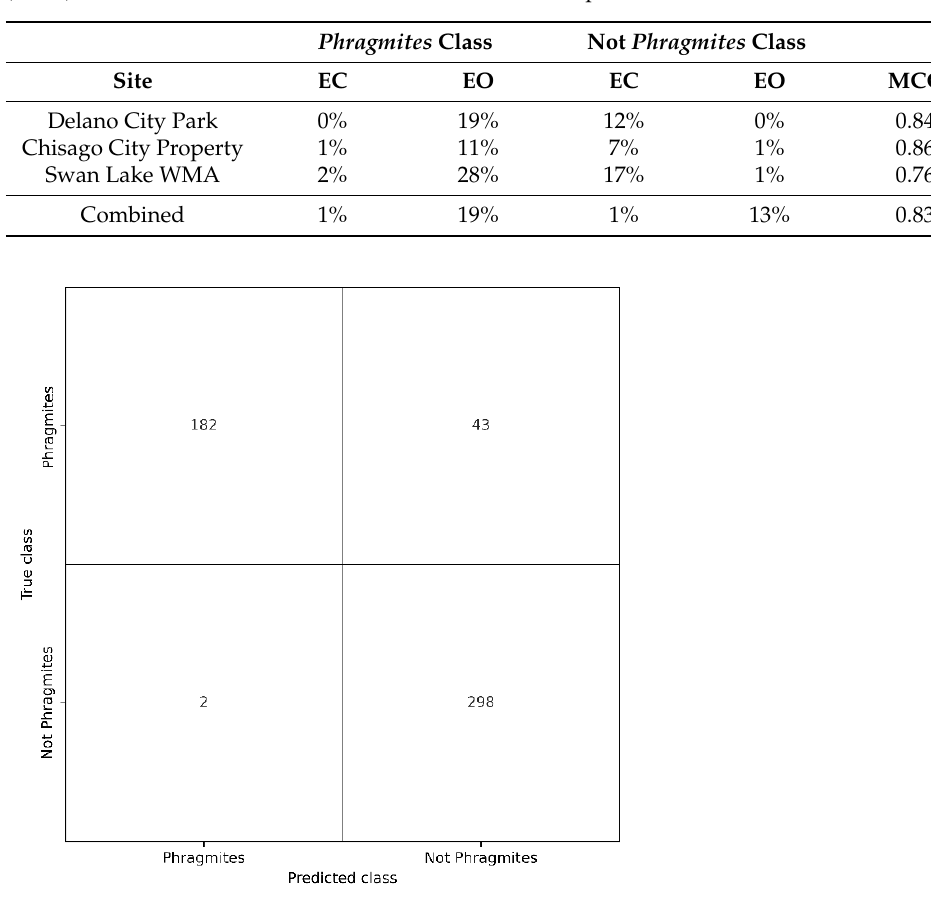
Figure 12. Combined confusion matrix for the three validation sites classified using a random forest with the post-ML OBIA rule set. A classification accuracy of 91% was achieved. The Phragmites